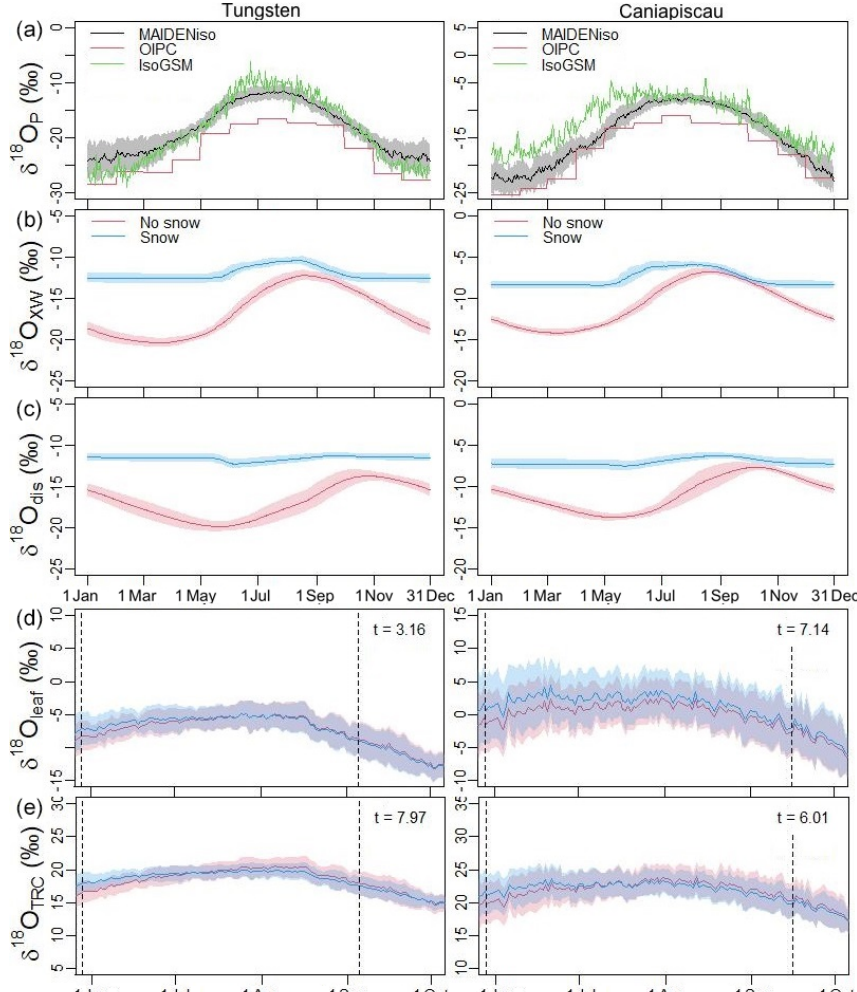
Figure 8. Simulated δ 18 O at different stages of the water cycle for the period 1979–2003 for the sites of Tungsten (left) and Caniapiscau (right). (a) The δ 18 O in precipitation ( δ 18 O P ) simulated by MAIDENiso using the NARR meteorology (black), monthly data from the Online Isotopes in Precipitation Calculator (OIPC, red) and mean from the IsoGSM dataset (green). (b) The δ 18 O in the xylem water ( δ 18 O XW ), (c) the δ 18 O in the discharge water ( δ 18 O dis ), (d) the δ 18 O in the leaf ( δ 18 O leaf ) and (e) in the tree-ring cellulose ( δ 18 O TRC ) for the model without snow (red) and with snow (blue). Shadows indicate the 2 σ variability for the same DOY within the 1979–2003 period. Vertical dashed lines in (d) and (e) indicate the start (budburst) and end of the growth season. Note that isotopic calculations are still made outside of this period, but no water is absorbed by the tree. Panels (d) and (e) include the t scores from a Welch t test, which show that the curves obtained for two versions of the model are